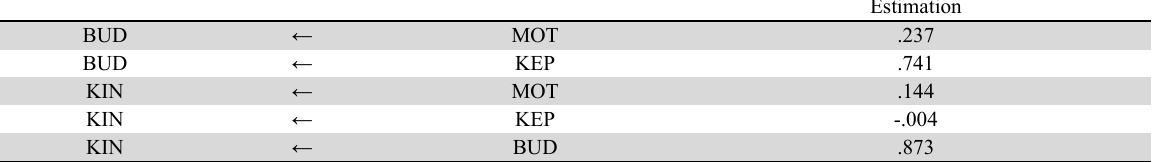
Standardized Regression Weight (Lambda) Motivation (MOT), Leadership (KEP), Organizational Cul- ture (BUD) and Performance Indicators